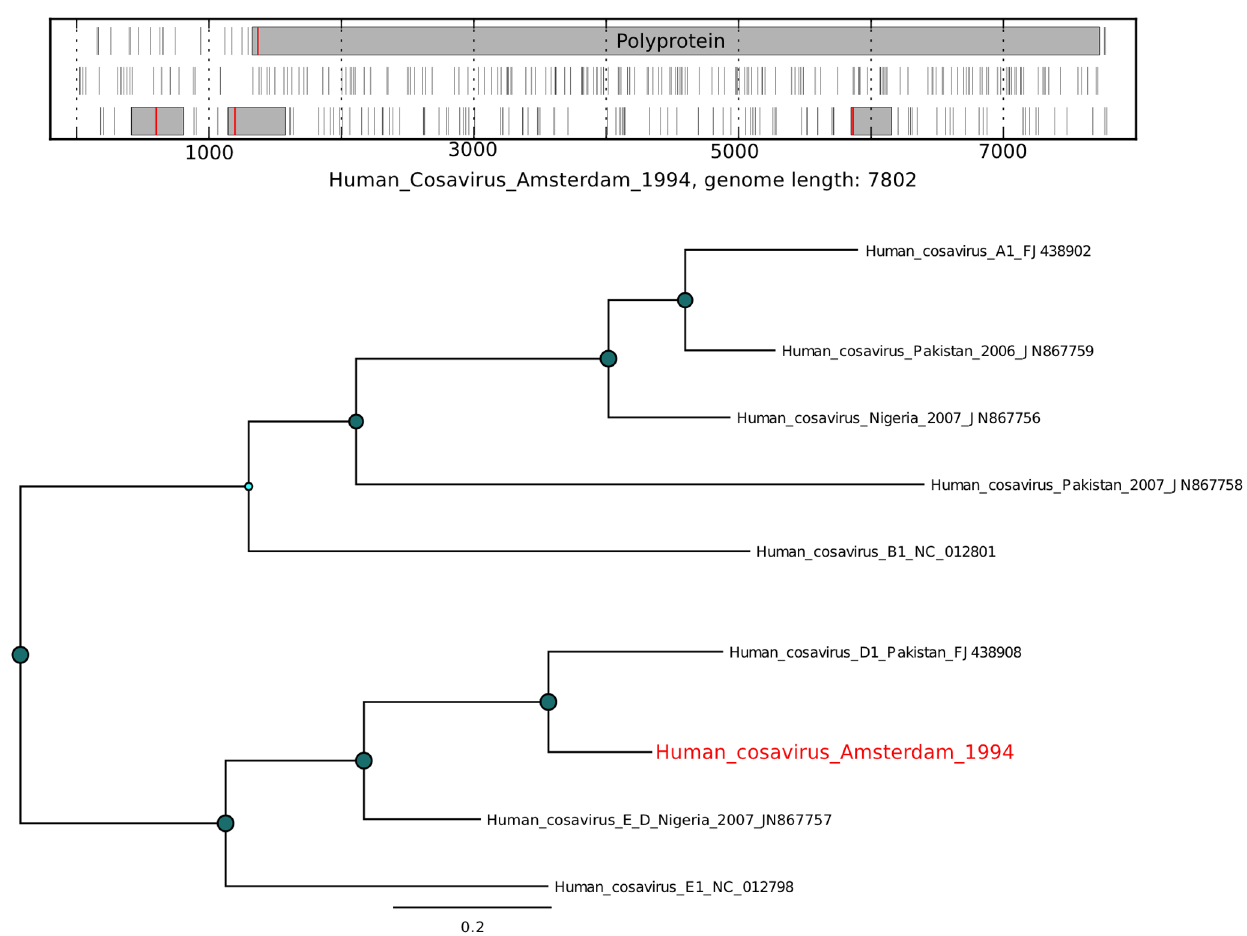
Figure 8. Open reading frame structure and phylogenetic analysis of the human cosavirus genome identified in this study. Analysis and graphical presentation was performed as described in the legend to Figure 7.